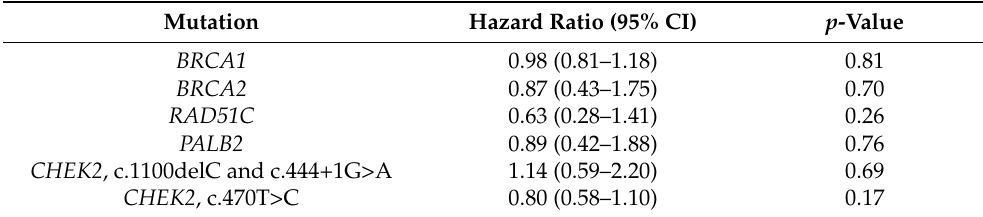
Table 3. Association of BRCA1 , BRCA2 , RAD51C , PALB2 , and CHEK2 mutations with all-case survival among unselected ovarian cancer